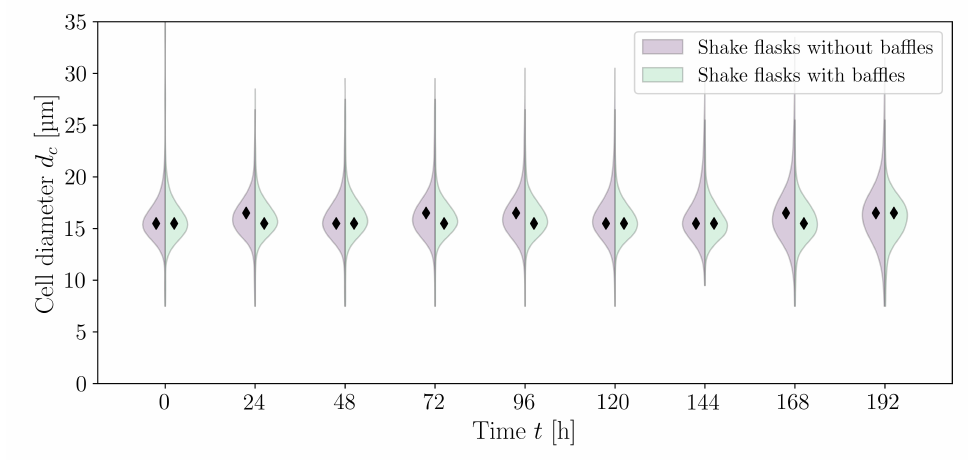
Figure 6. Cell size distribution over time for the shake flask cultivations with ( n r = 5) and without baffles ( n r = 5). Black diamonds ( (cid:7) ) mark the median cell diameter.